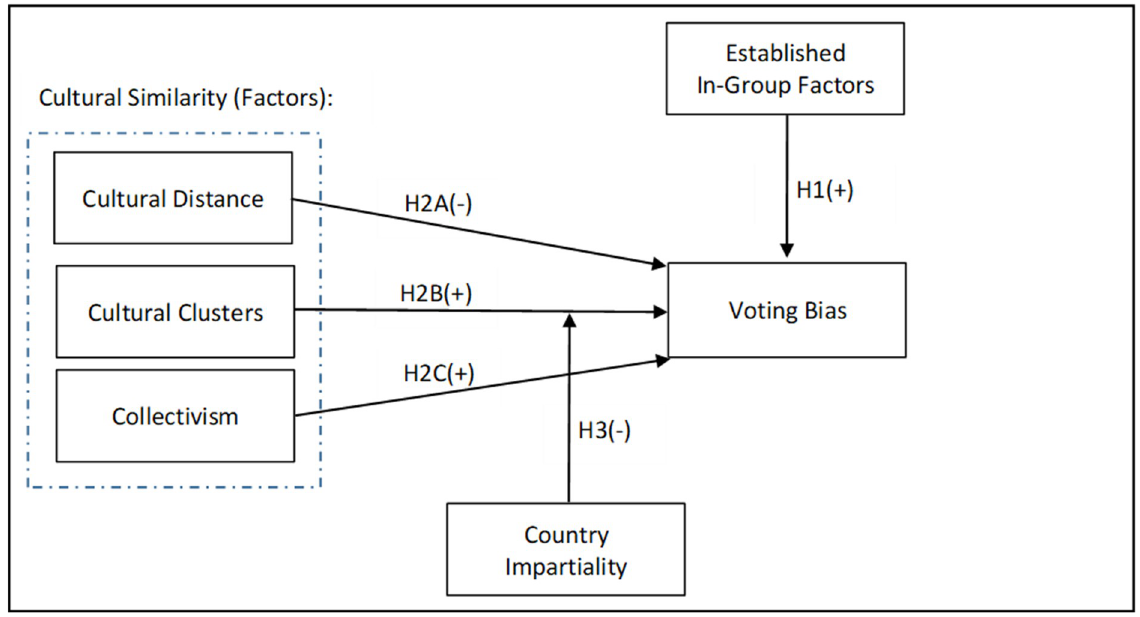
Fig 1. Research design and hypotheses.